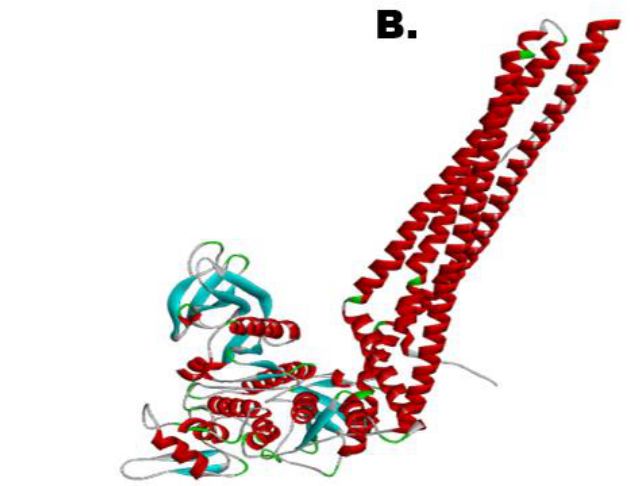
Figure 5. ( A ). Refined 3-D structure of vaccine candidate. ( B ). Refined 3-D structure of IKBKE receptor.